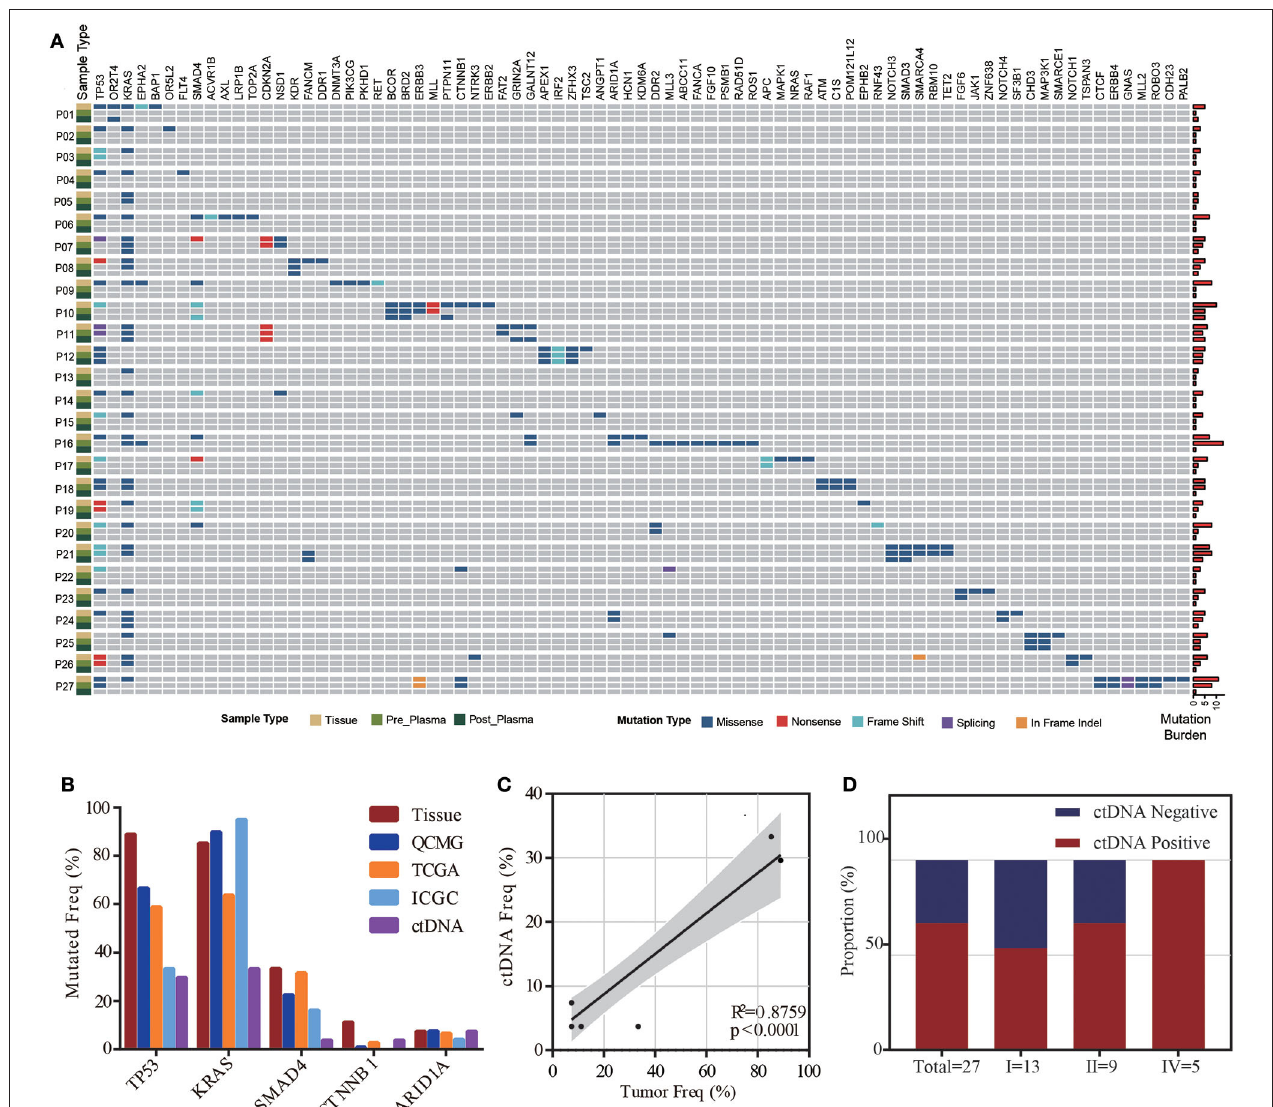
FIGURE 1 | ctDNA and tissue mutational landscape in patients with pancreatic ductal adenocarcinoma (PDAC). (A) Heatmap illustrating tissue, preoperative and postoperative ctDNA mutations identified in this study. Right bars indicate the mutation burden of each sample. (B) Comparison of mutation frequencies in our study (tissue and preoperative ctDNA) and public tissue databases (QCMG, TCGA, and ICGC). (C) Correlation between mutation rates in preoperative ctDNA and tumor DNA. (D) The detectable rate of different clinical stages in preoperative plasma samples from 27 PDAC patients.